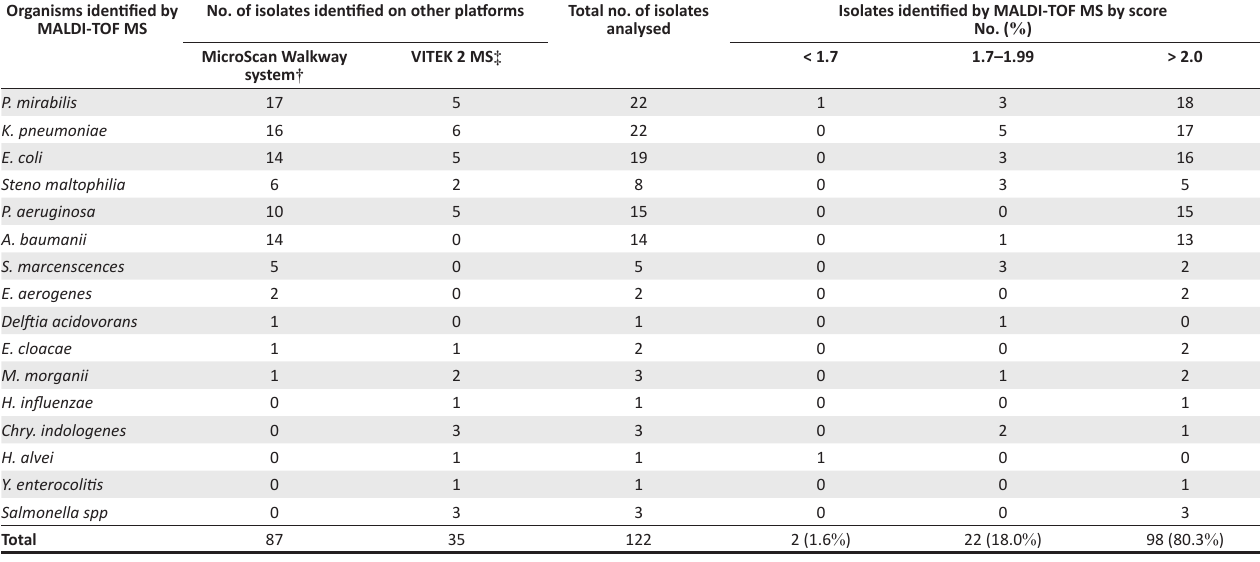
TABLE 1: Gram-negative bacterial isolates identified ( N = 122), Bloemfontein, South Africa, 15 July 2013 to 30 September 2013. Organisms identified by No. of isolates identified on other platforms MALDI-TOF MS